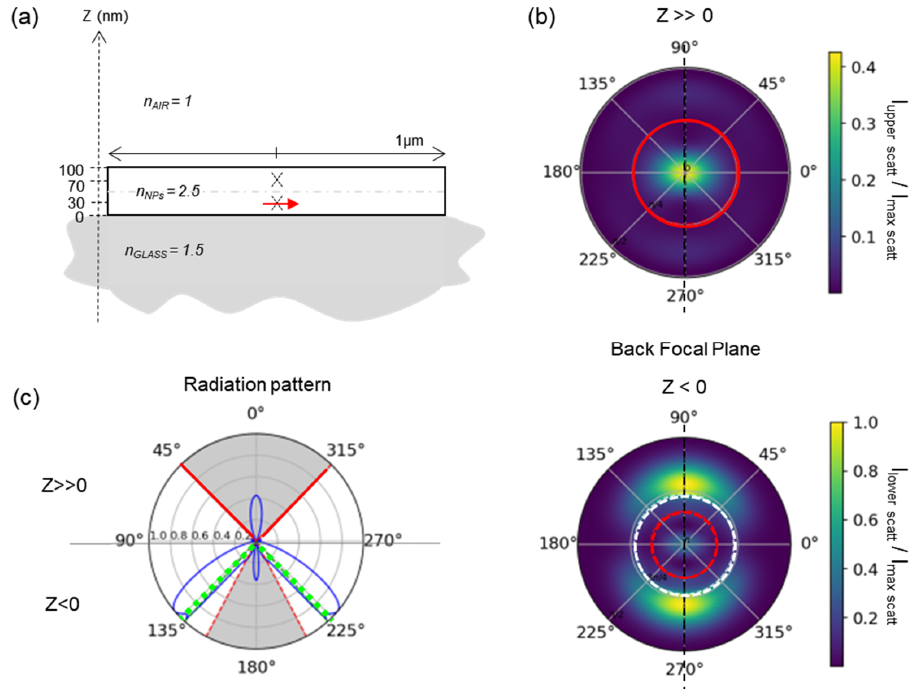
Figure 6. ( a ) Schematic crossed section of the NP combinatorial pattern model used for simulations: 100 nm thick disk of n NP = 2.5 on top of a glass substrate of n glass = 1.5. The glass substrate corresponds to the lower half space. A single dipolar source emitter is placed either at z = 30 nm or 70 nm (on dotted crosses), respectively, in the first and second levels of the NP assembly. In this example, a dipolar source emitting in the red region at λ = 645 nm (red arrow) is positioned at z = 30 nm, mimicking a first level of red NP. ( b ) Fourier plane of the emitted field, in relative intensity, within ( top ) the upper half space in air (z >> 0), and ( bottom ) the lower half space in glass (z < 0). ( c ) A radiation pattern (blue line), in relative intensity, corresponding to a cross-section along the black dashed line presented in ( b ). The maximal angle of collection of the microscope objective is represented for the upper half space by the red lines (44.4 ◦ ) and for the lower half space by the red dashed lines (27.8 ◦ ). The Total Internal Reflection angle represented by the green-dashed line in ( c ) corresponds to the white-dashed line in ( b )